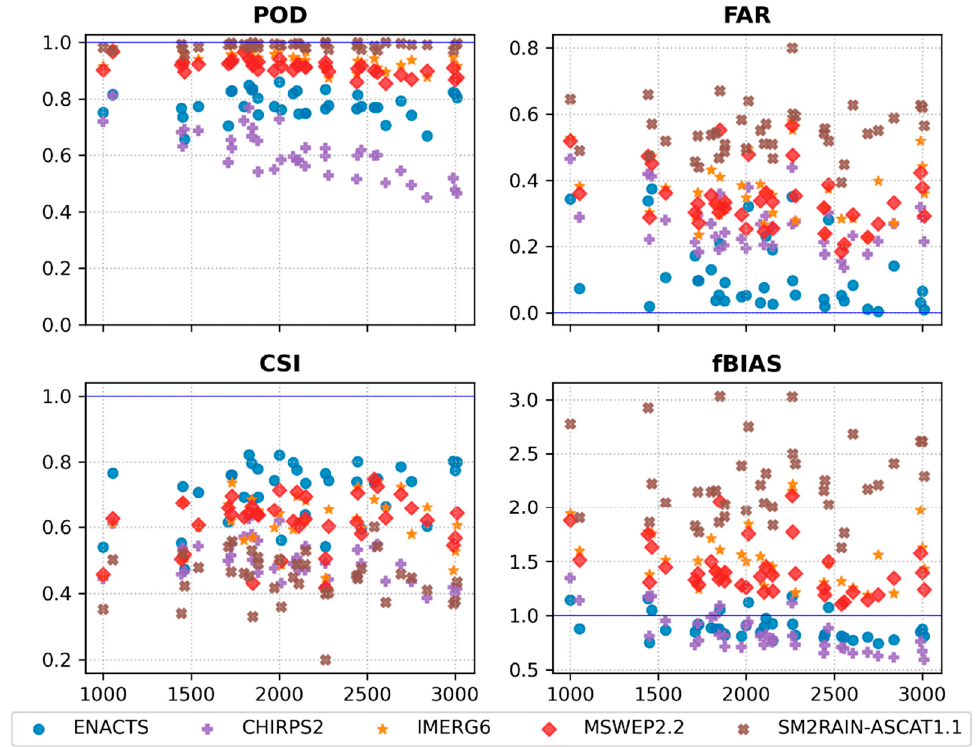
Figure 4. Categorical indices of precipitation datasets as classified by elevation over UBNRB. From left to right and top to bottom: probability of detection (POD), false alarm ratio (FAR), critical success index (CSI), and frequency bias (fBIAS). The horizontal blue line indicates the respective optimum value for each measure.